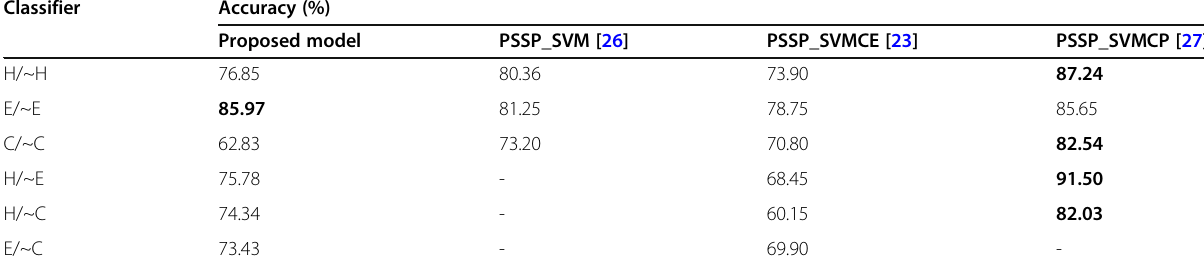
Table 3 Accuracy comparison of various algorithms for protein secondary structure prediction Classifier